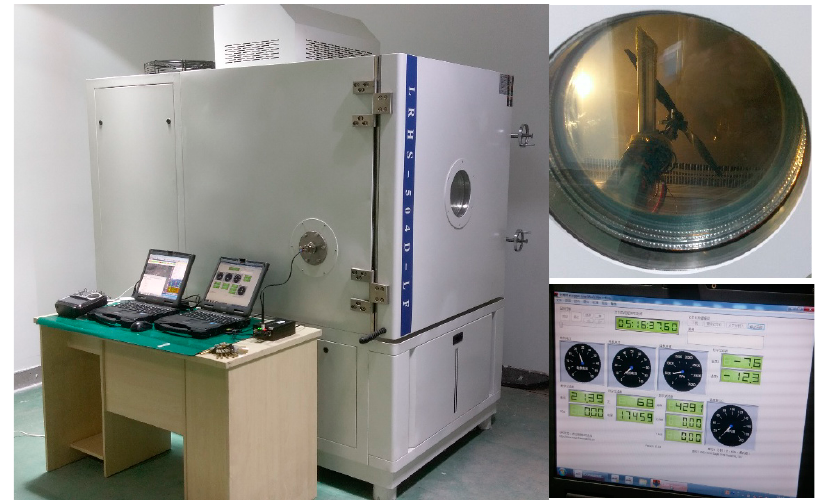
Figure 3. The discharge test of energy system in low-temperature and low-pressure test